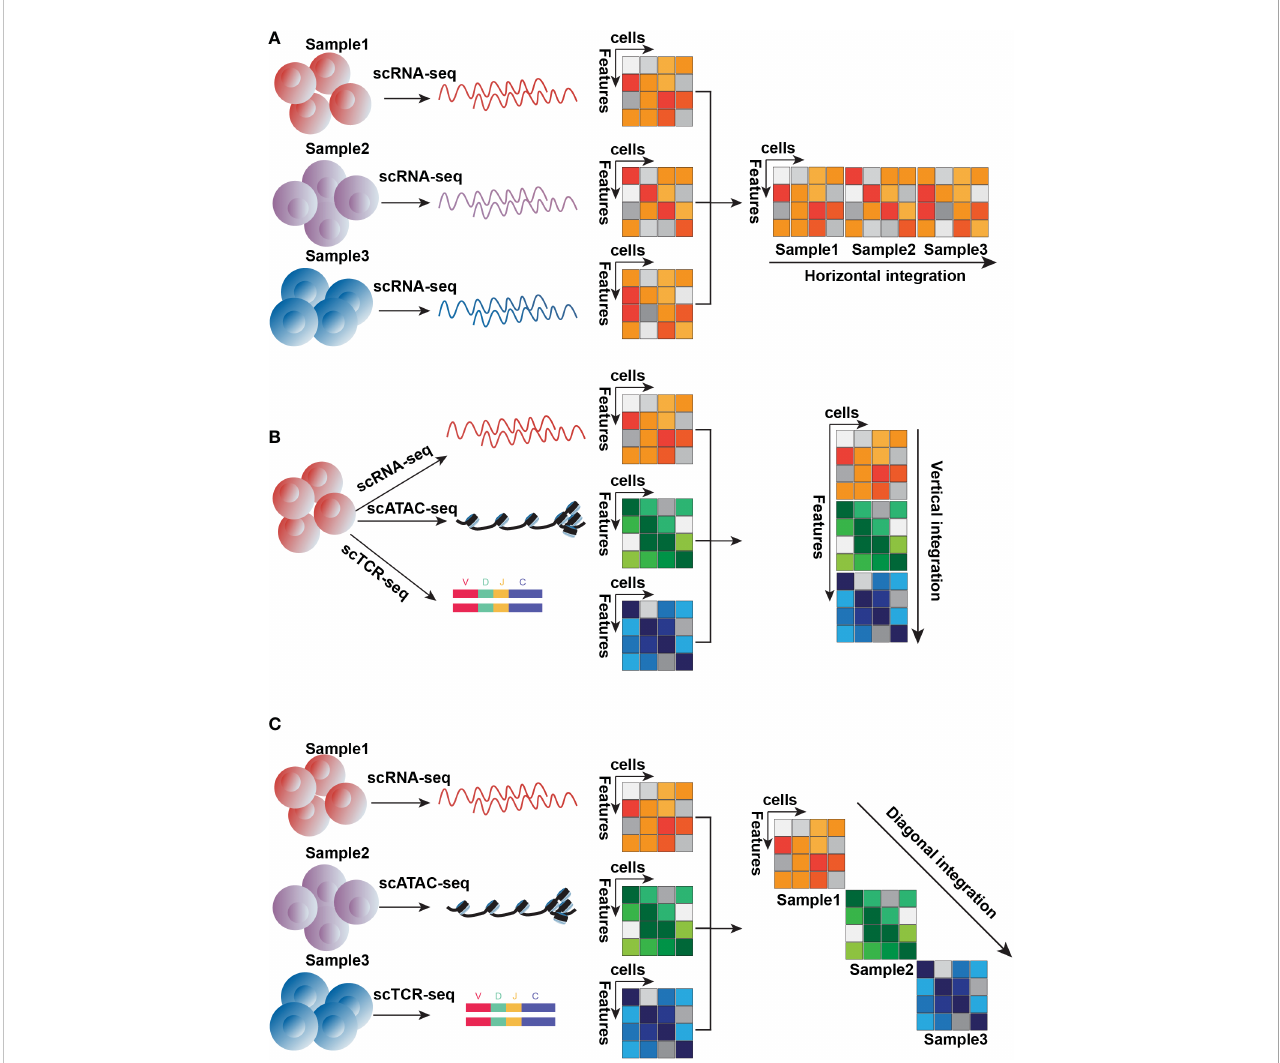
FIGURE 4 Three conceptual types of integration approaches. (A) . The horizontal integration approach is designed for distinct samples detected by the same technique, here is an example of scRNA-seq (B) . Vertical integration is suitable for subpopulations of the same sample detected by distinct techniques, here is an example of scRNA-seq, scATAC-seq, and scTCR-seq (C) . Diagonal integration is designed to integrate different samples measured by different techniques, here is an example of scRNA-seq, scATAC-seq, and